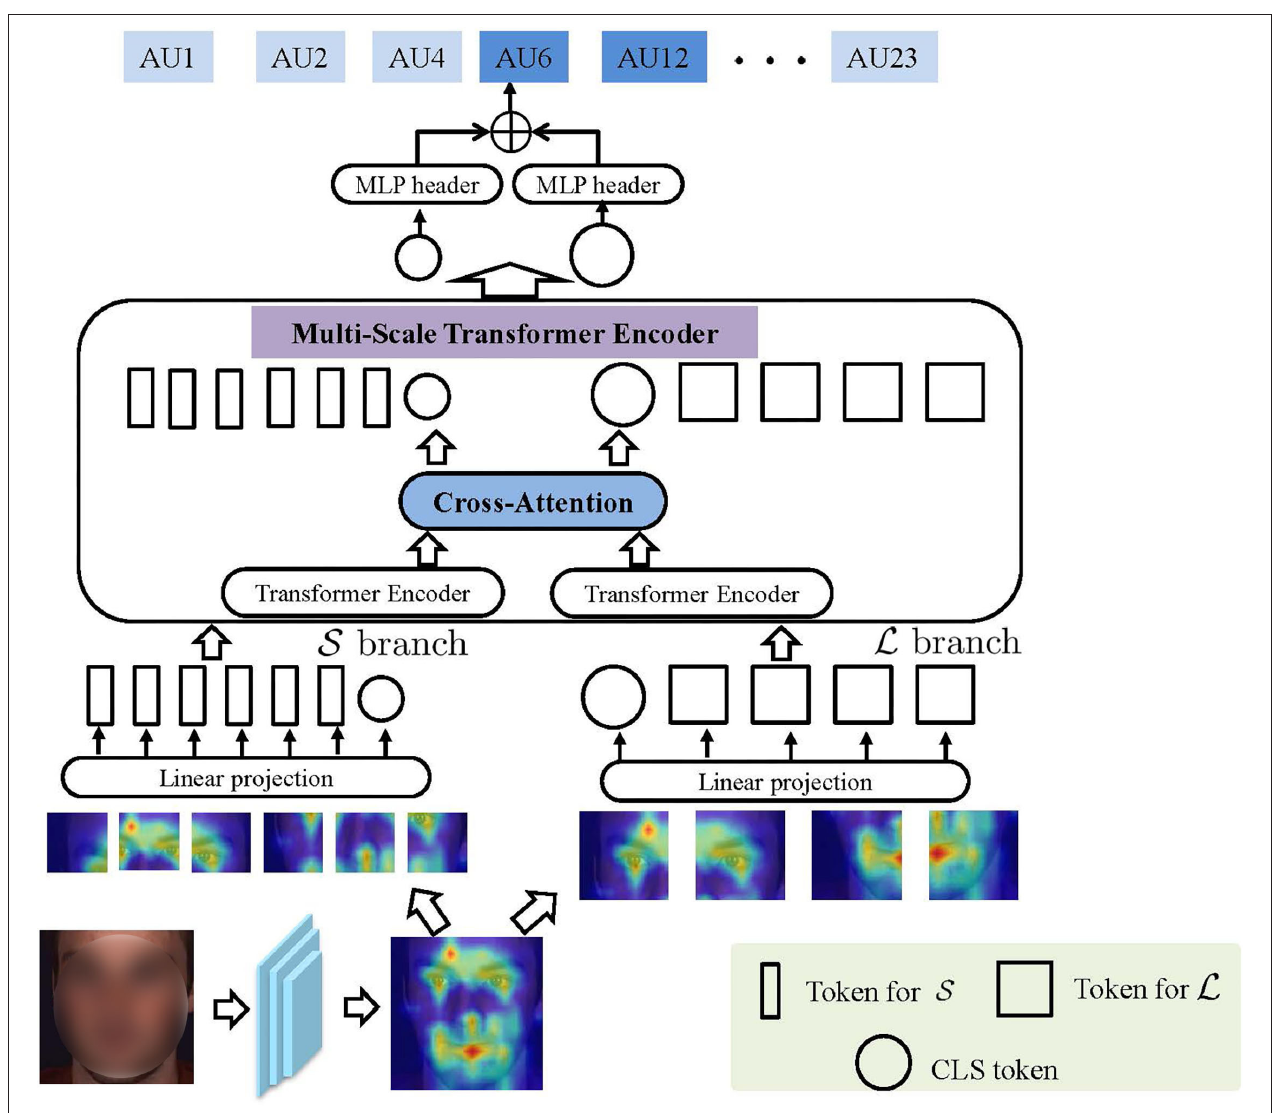
FIGURE 2 | The main idea of the proposed progressive multi-scale vision transformer (PMVT). With the encoded convolutional feature map X con , PMVT uses L and S branch transformer encoders that each receives tokens with different resolutions as input. The two branches will be fused adaptively via cross-attention